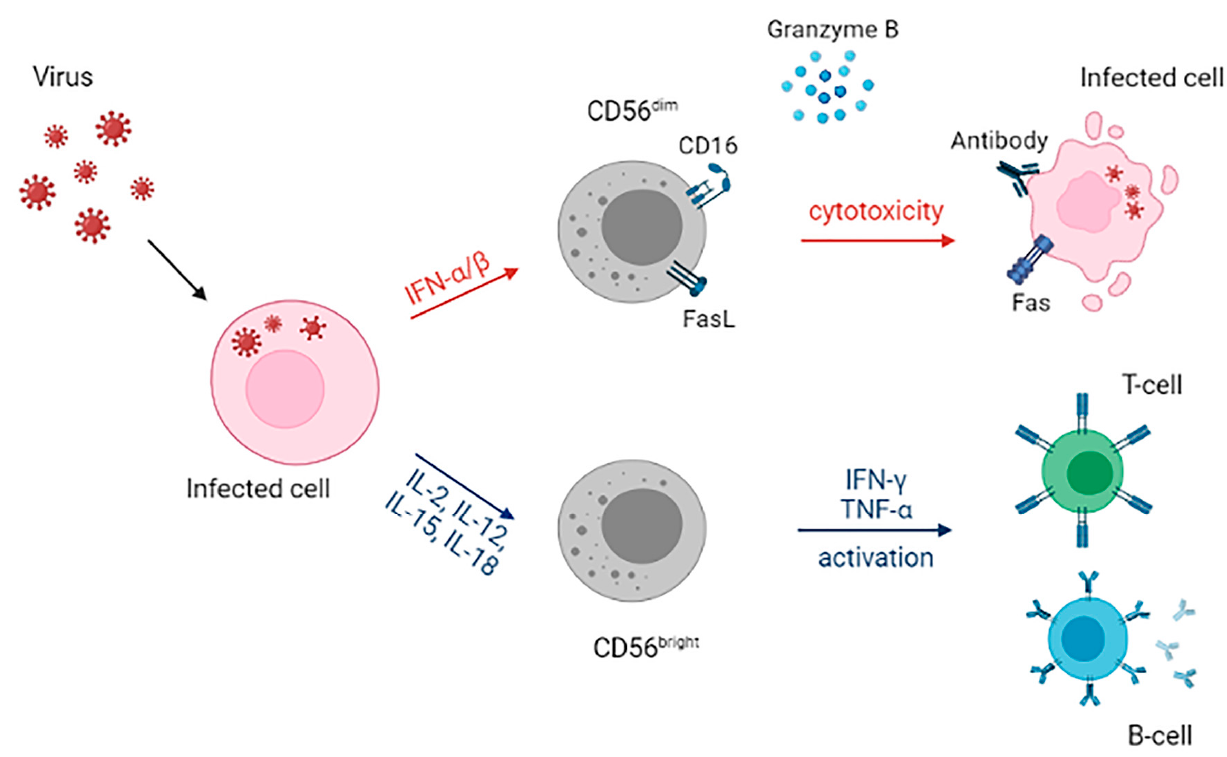
Figure 1. NK cell activation during infection. Virus can induce the production of IFN- α /- β (interferon- α /- β ) and IL (interleukin)-2, IL-12, IL-15, and IL-18 by infected cells, which respectively stimulate NK cells cytotoxicity and adaptive immunity activation. CD56 dim NK cells have a cytotoxic function that can be mediated by Granzyme-B production, Fas/FasL (Fas ligand) interaction and CD16 binding with the Fc (constant fraction) of antibodies. Adaptive immunity modulation is mediated by CD56 bright NK cells through the secretion of IFN- γ (interferon- γ )/TNF- α (tumor necrosis factor- α ), that affect T- and B-cells.